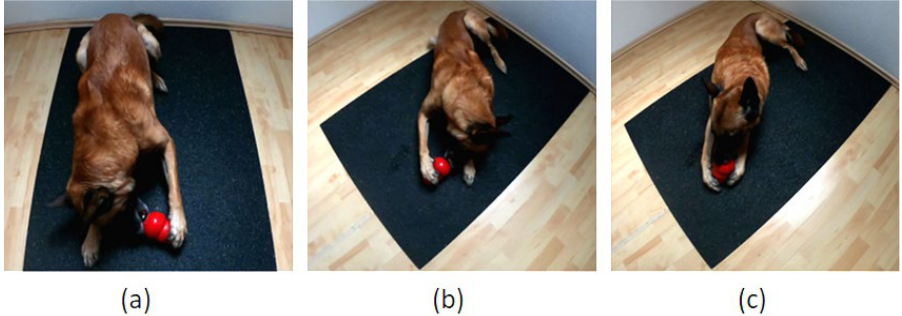
Figure 2. ( a ) Kong™ is stabilized with the left paw. ( b ) Kong™ is stabilized with the right paw. ( c ) Both paws stabilize the Kong™.